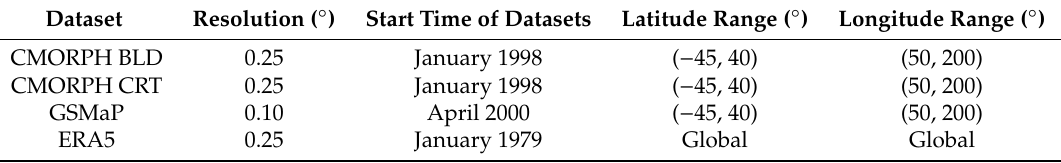
Table 1. Details of the precipitation datasets used. CMORPH BLD and CMORPH CRT refer to the blended and corrected versions of the Climate Prediction Center Morphing Technique datasets; GSMaP refers to the Global Satellite Mapping of Precipitation dataset; and ERA5 refers to fifth generation ECMWF